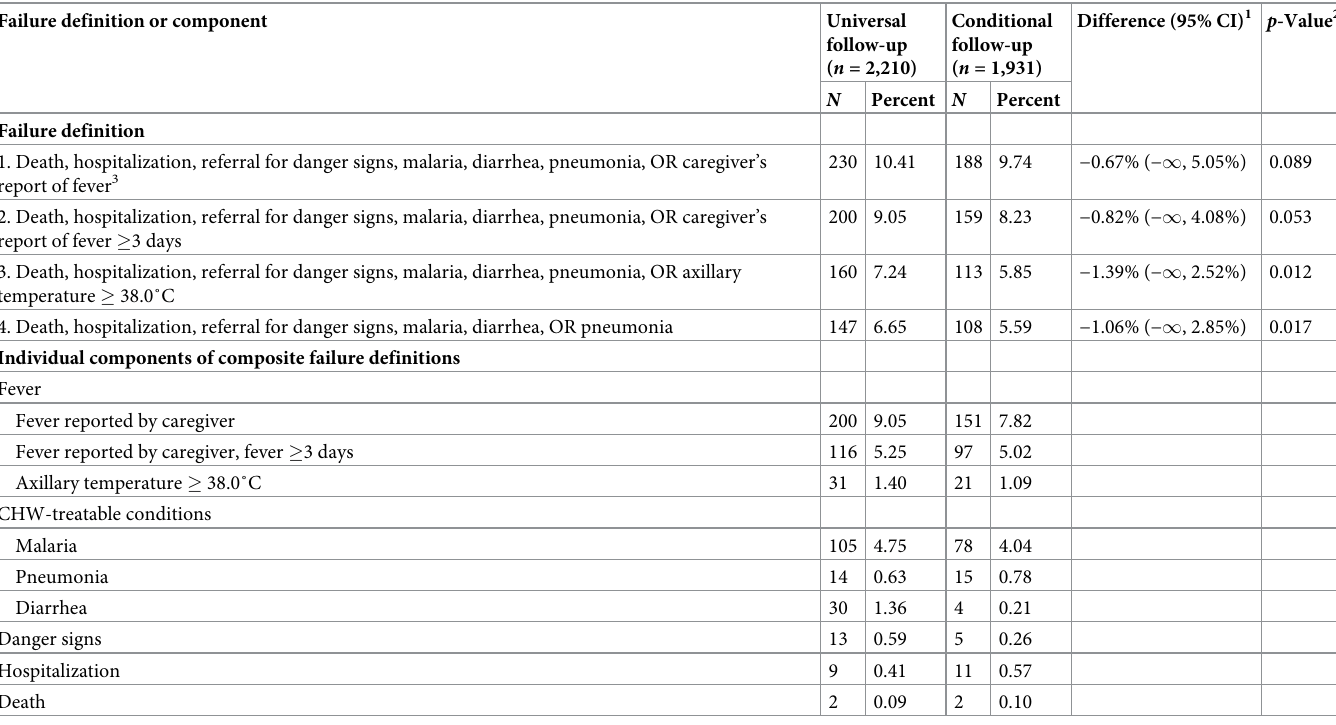
Table 4. Proportion of children meeting the failure definitions and individual components of the failure definitions at day 8 visit (per-protocol